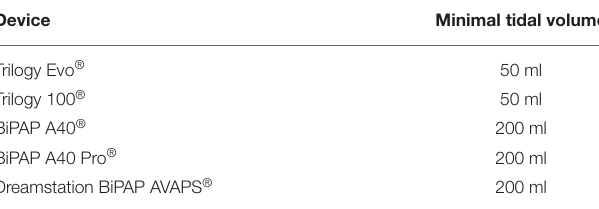
TABLE 2 | Minimum tidal volume on AVAPS enabled